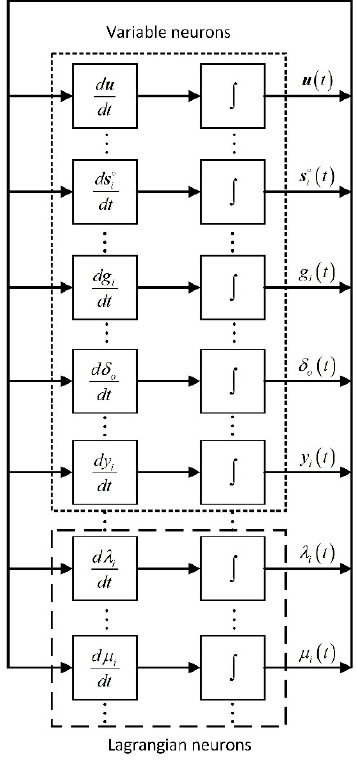
Figure 2. The structure of the proposed LPNN with unknown start transmission time and sensor position uncertainties.